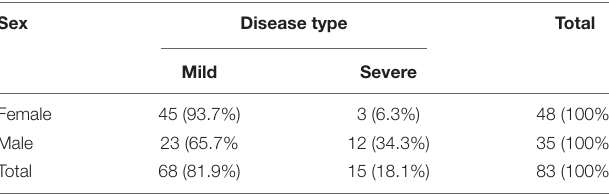
TABLE 2 | The disease types of the H. pylori positive ( N = 83), males ( N = 35) and females ( N = 48) in the